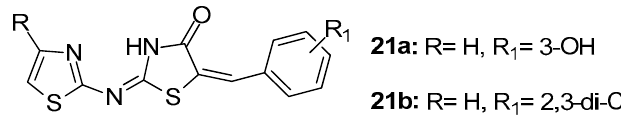
Figure 23. Chemical structures of 5-arylidene-2-(1,3-thiazol-2-ylimino)-1,3-thiazolidin-4-ones 21a , 21b .